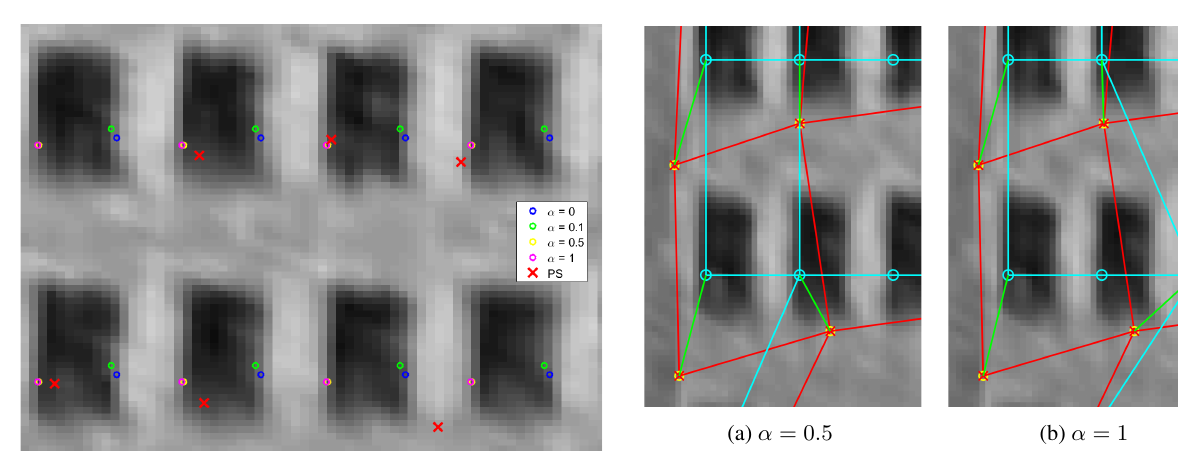
Figure 8: Different positions of lattice points as a function of the parameter α . Background: cut out grayvalue image of the facade. The original PS positions are marked as red crosses. The resulting lattice node positions which are dependent on the parameter α are marked as colored circles.